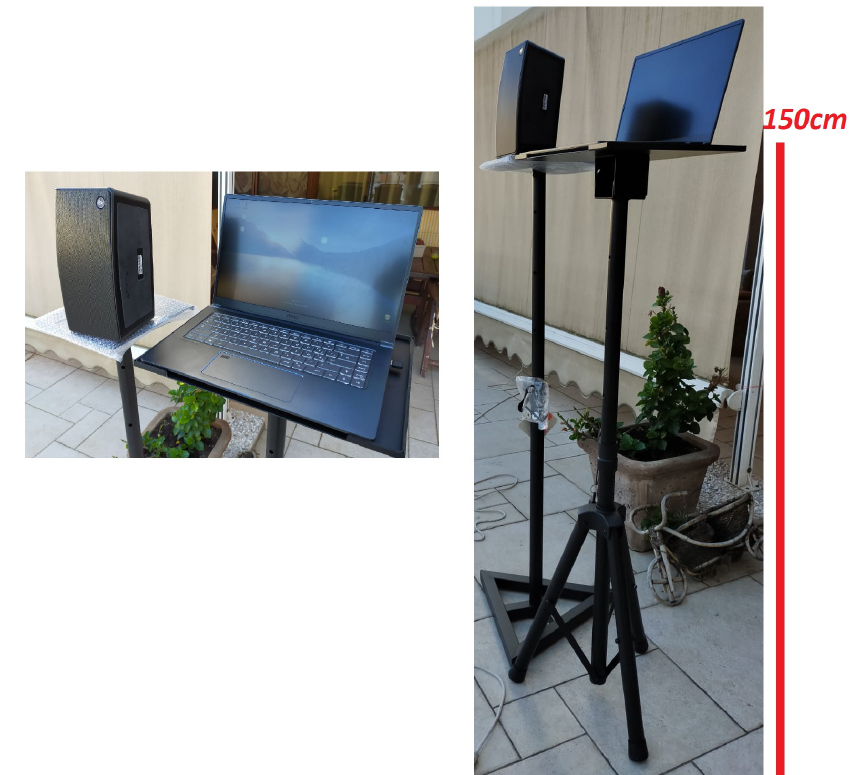
Figure 5. Beacon set-up with laptop integrated microphone and external loud-speaker.